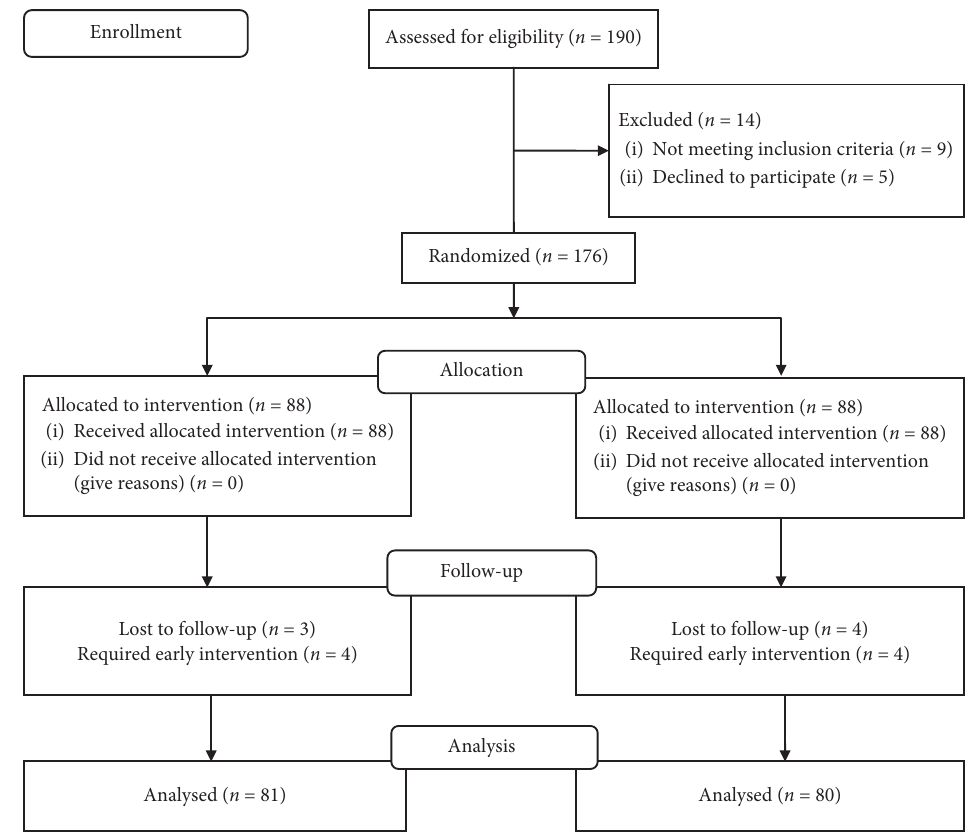
Figure 1: Patient flow diagram.